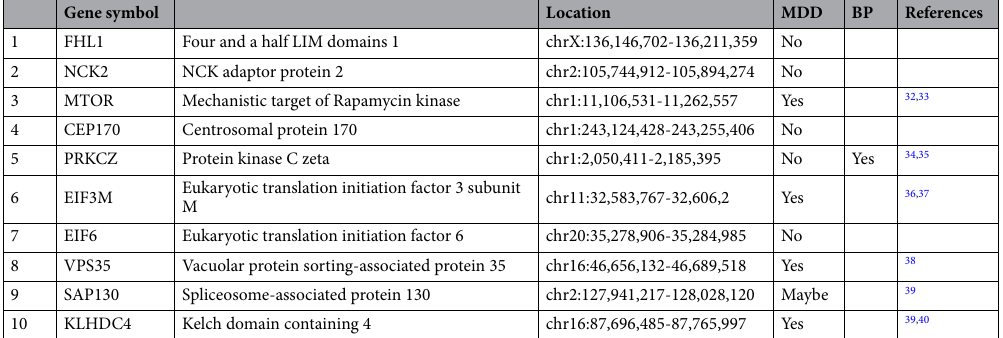
Gene symbol Location MDD